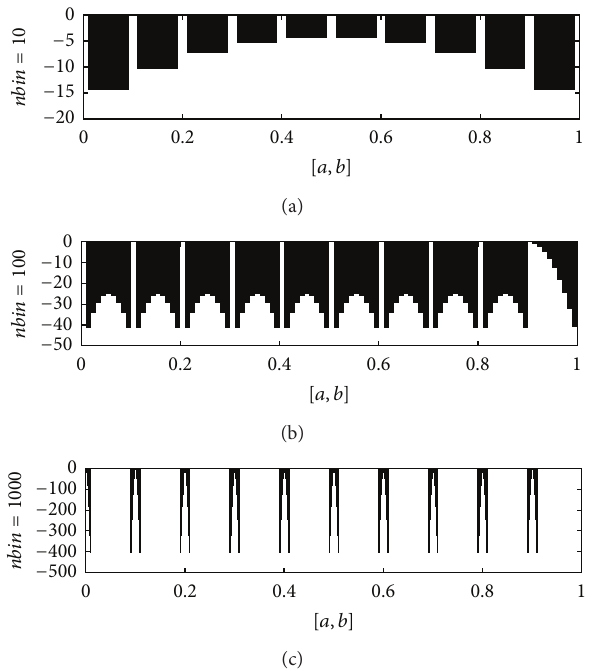
Figure 6: Example of advanced shifted histogram algorithm run- ning for different bins: 10, 100, and 1000.